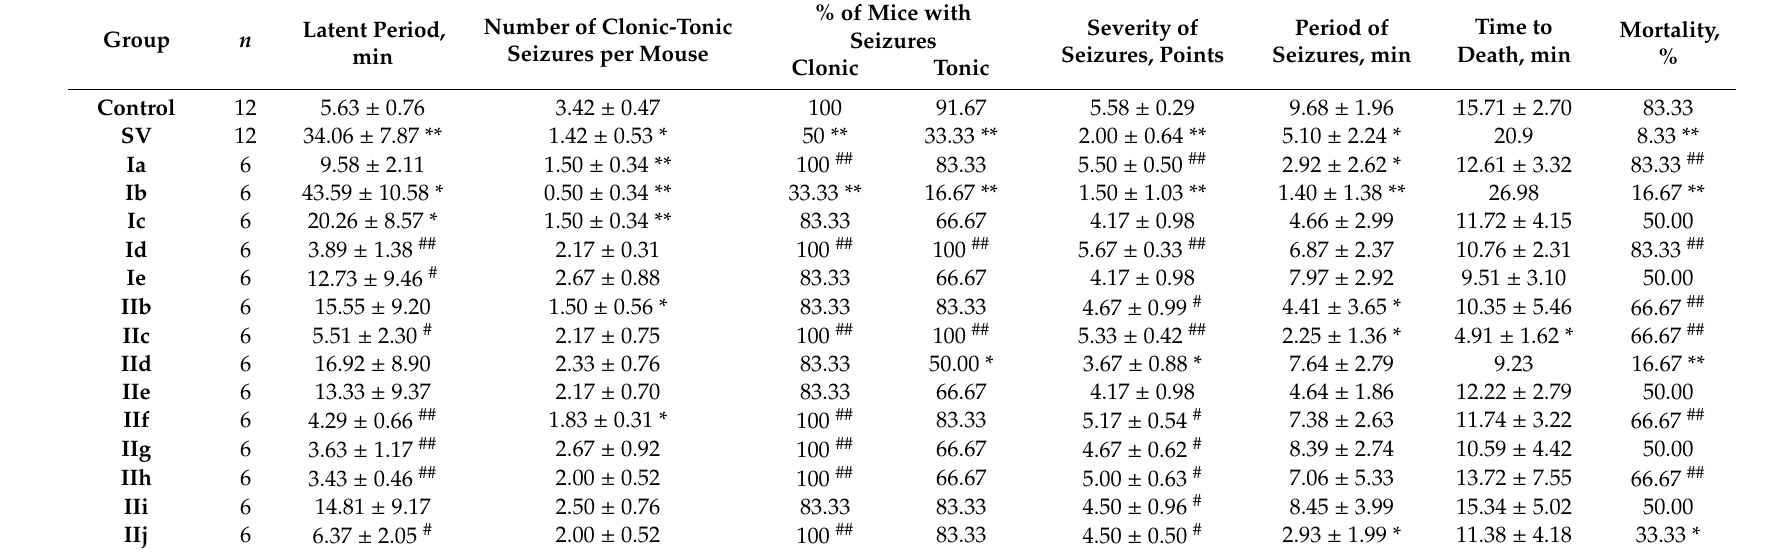
Table 1. Anticonvulsant e ff ect of tested compounds in PTZ